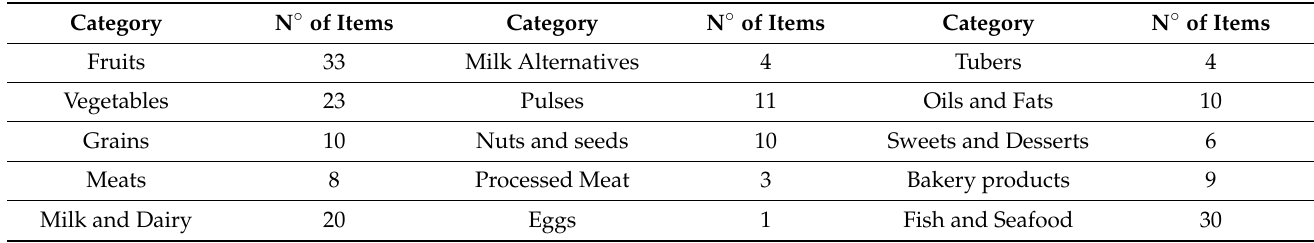
Table 1. Food commodity division into food